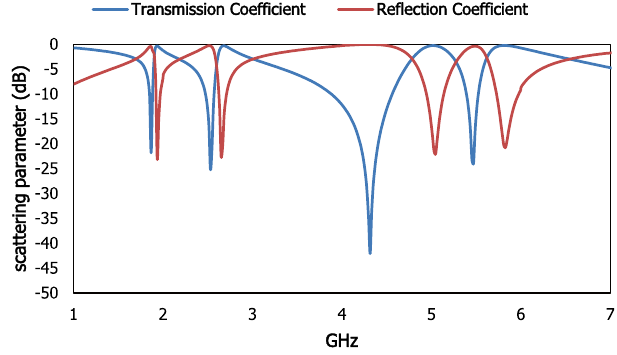
Figure 2. Scattering result of the proposed metamaterial unit cell.